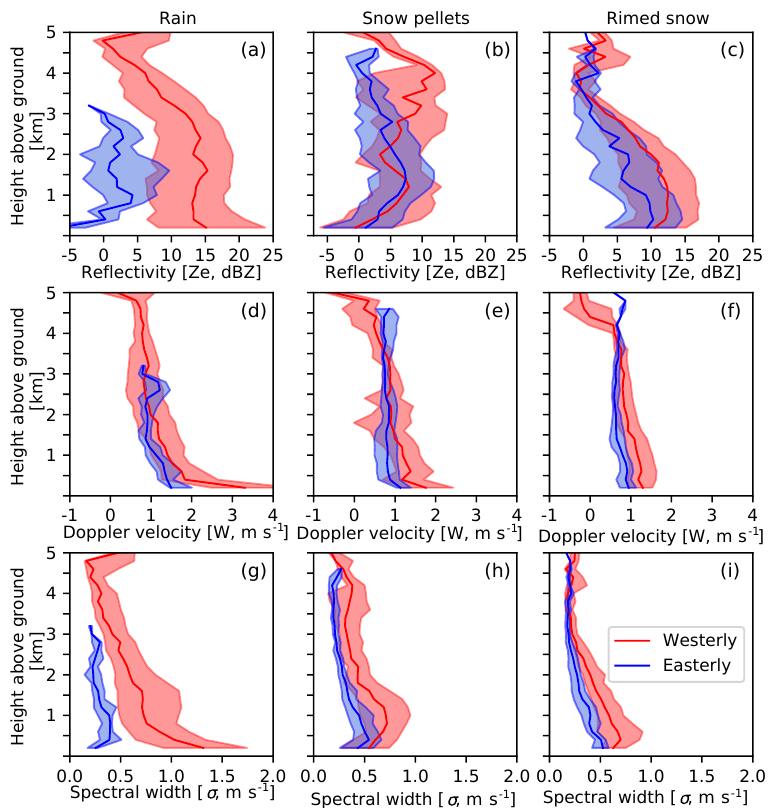
Figure 14. MRR2 profiles with height (above ground level) associated with both westerly (downslope) and easterly (upslope) flow events over the March-April 2015 period for three types of precipitation: (a, d, g) rain, (b, e, h) snow pellets and (c, f, i) rimed snow. (a–d) are reflectivity, Z e (dBZ); (d–f) are Doppler velocity, W (ms − 1 ); and (g–i) are spectral width, σ (ms − 1 ). The height is above the radar and data from the first 200m are not used to eliminate surface-induced noise. The colour shading is the region bound by the 25th and 75th percentiles. The median is the bold